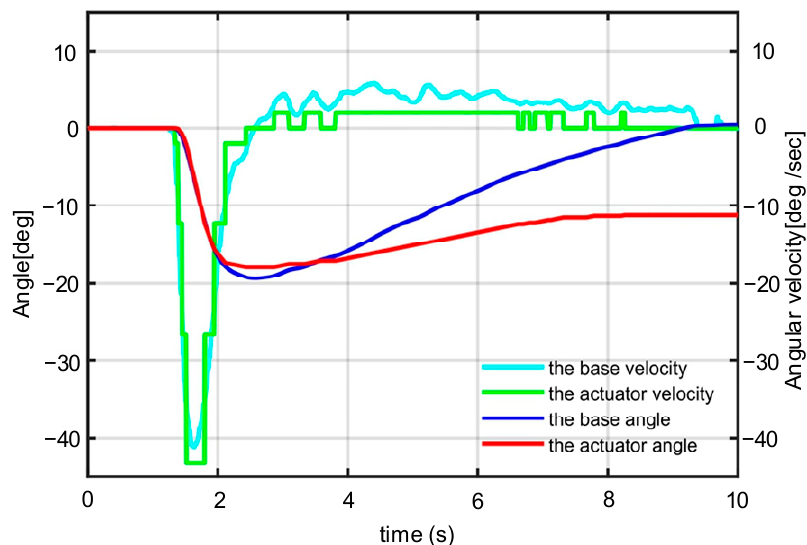
Figure 6. The influence of the dead zone in feedforward velocity tracking.